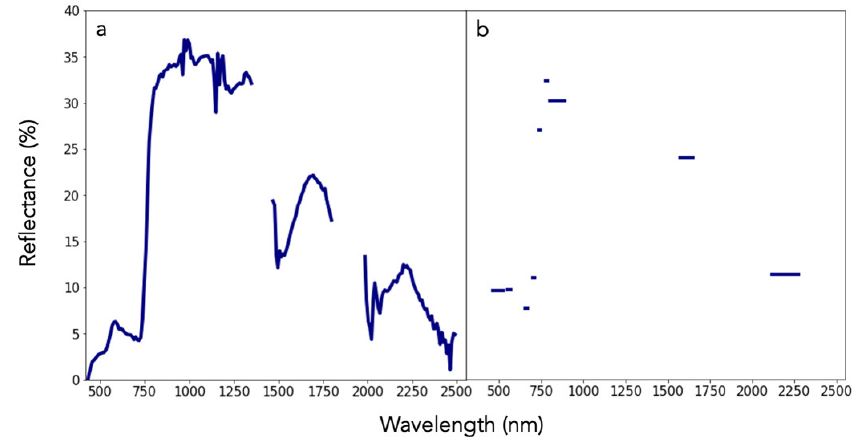
Figure 1. Bottom-of-atmosphere reflectance spectra (400 to 2500 nm) from ( a ) the airborne visi- ble/infrared imaging spectrometer (AVIRIS) and ( b ) Sentinel-2. While AVIRIS data represent 224 contiguous, equally sized bands (channels), Sentinel-2 data are discrete representations of the electromagnetic spectrum with variable bandwidths.